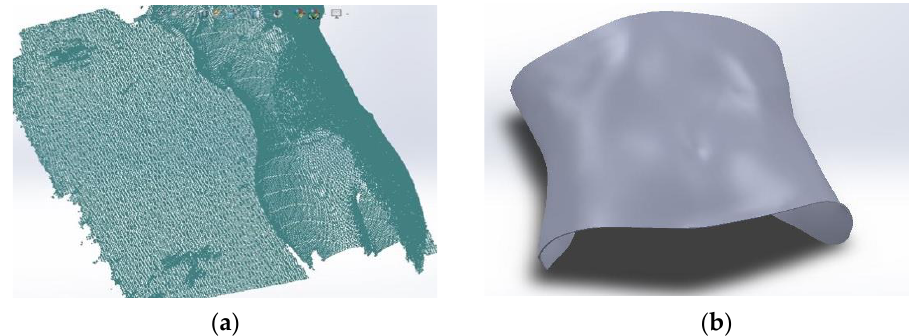
Figure 4. ( a ) Point cloud importation to SW and ( b ) final surface reconstruction.